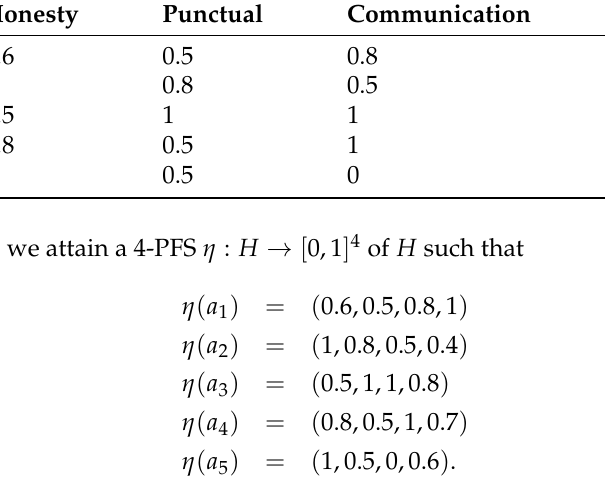
Figure 1 is the graphical representation of 4-PFS: